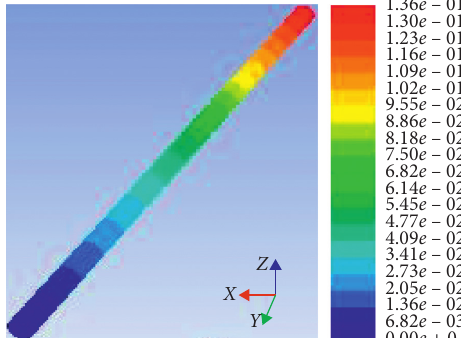
Figure 17: Pressure cloud diagram of the threaded pipe.